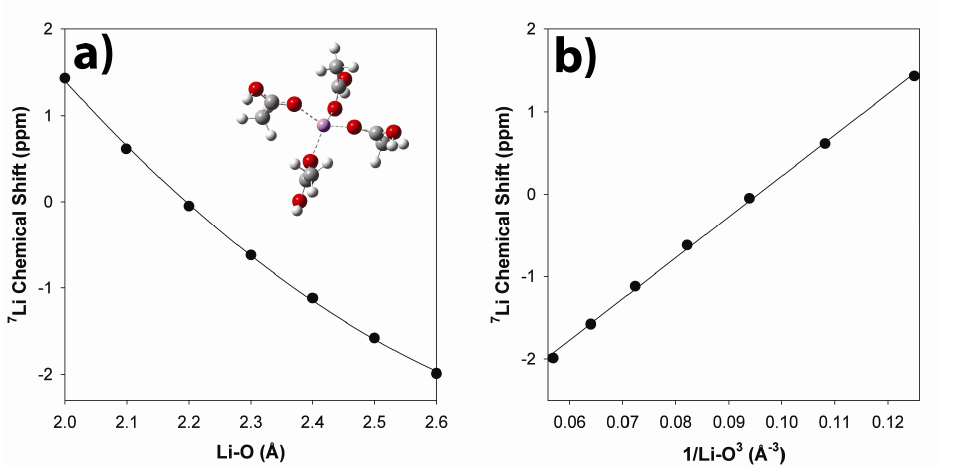
Figure 10. Ab initio calculations of the 7 Li NMR chemical shift variation of the a) Li-O and b) (Li-O) −3 distances in the tetra-acetic acid-Li